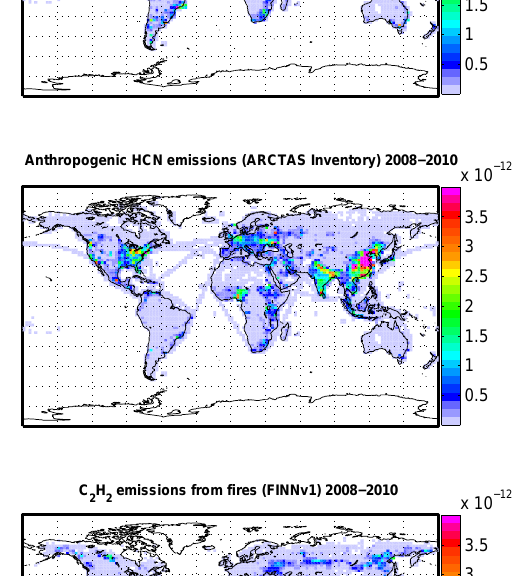
Table 1. Global C 2 H 2 and HCN emission sources (Tg(species)/year) during the period 2008-2010 from the dataset used in MOZART-4.